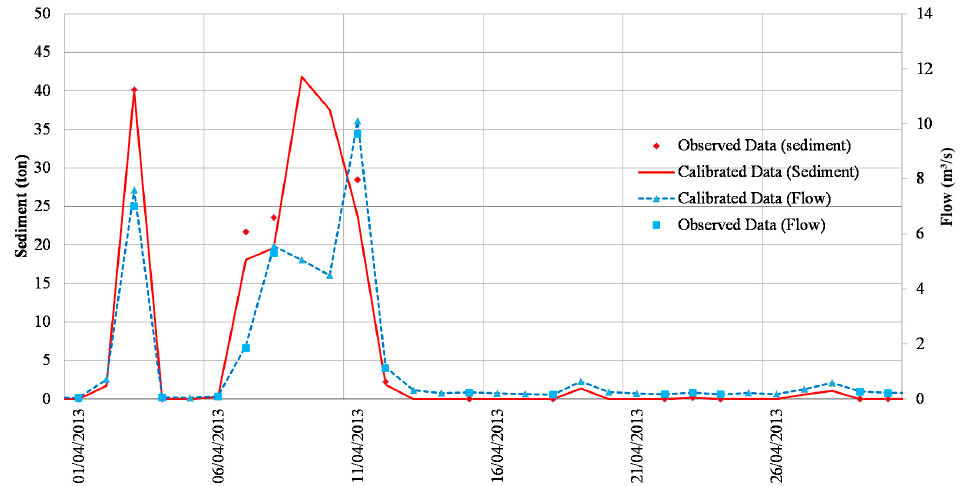
Figure 4. Calibrated (simulated) and observed sediment delivery and flow from sub ‐ basin 71. Table 3. Calibration parameters.